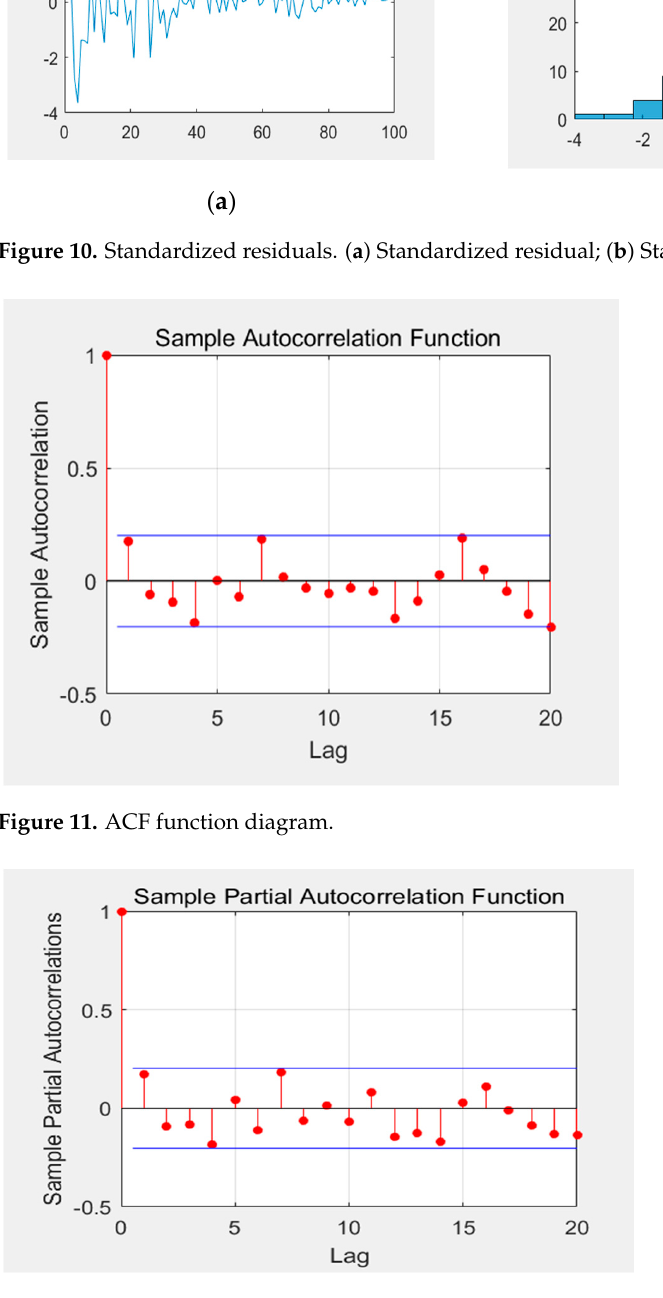
Figure 13. Residual QQ. 5. Latency Prediction Algorithm Based on Neural Networks Artificial neural networks have strong advantages in tackling the problem of latency prediction. Data transmission delays in vehicular networks are neither random in nature, or unpredictable. Within a certain range of time, from the above research and analysis, it can be found that the transmission delay of the network has strong autocorrelation, and there is a certain nonlinear relationship between the network latency at the next time -step and that of the preceding time- step. Furthermore, the latency in the whole local range